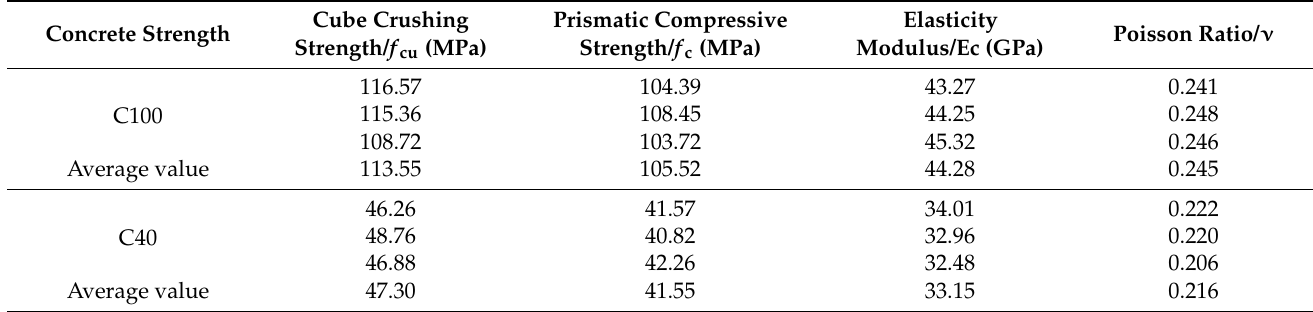
Table 3. Mechanical properties of reinforcement and structural steel.